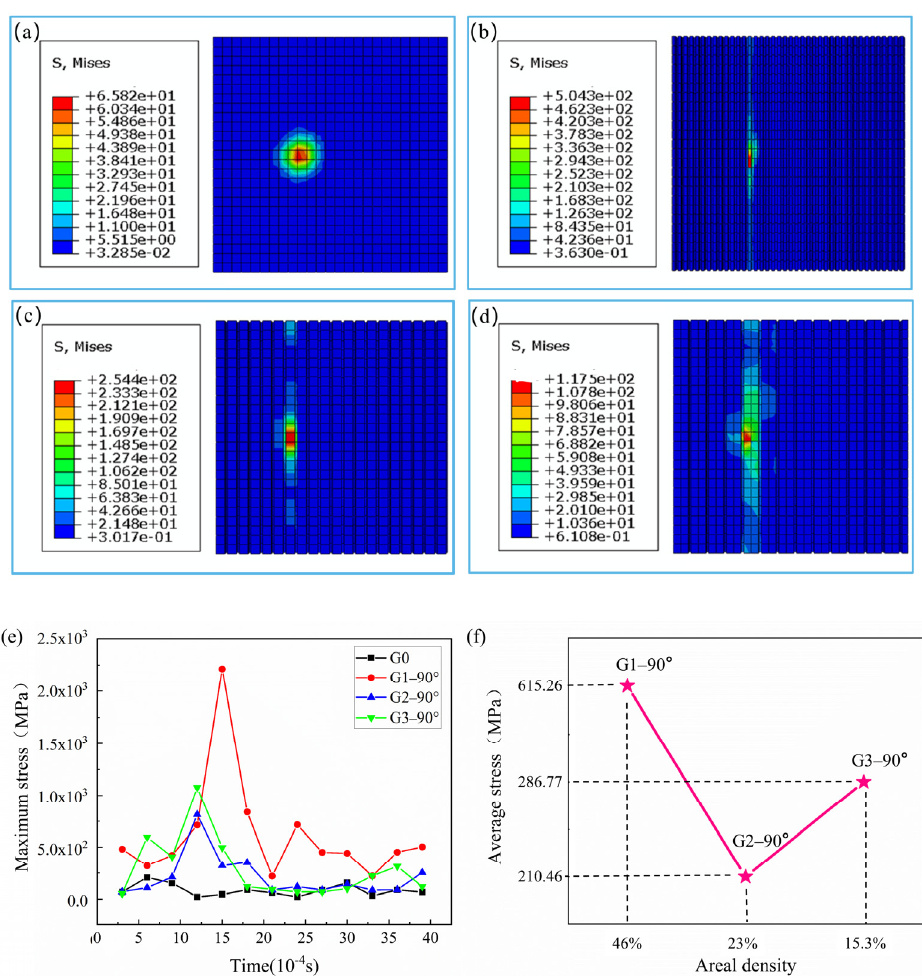
Figure 5. Simulation results of the stress field of the ( a ) G0, ( b ) G1, ( c ) G2, and ( d ) G3 samples. ( e ) Maximum stress distribution curves and ( f ) the relationship between the areal density and average stress of samples when the sliding direction was perpendicular to the groove textures.